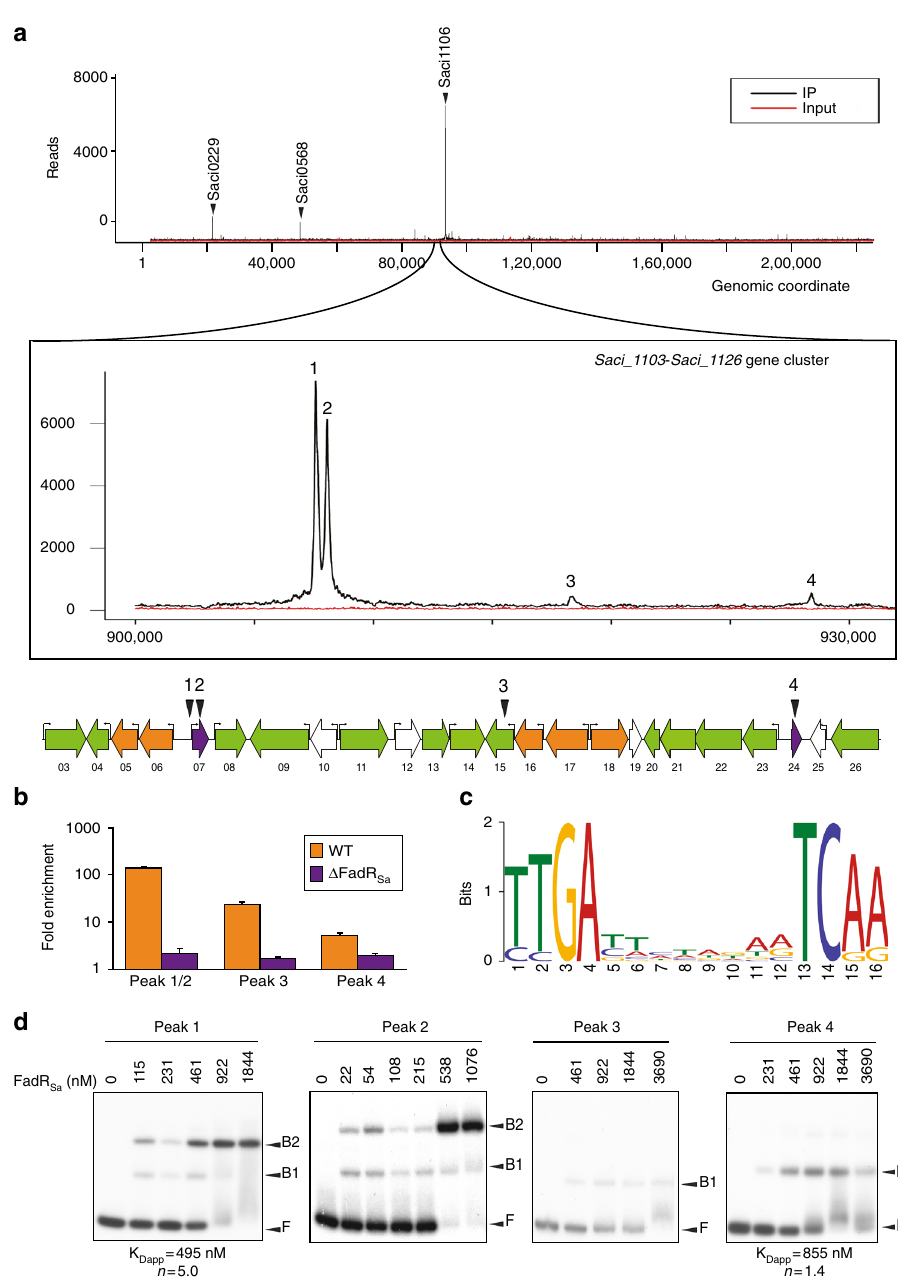
Fig. 2 FadR Sa interacts with four genomic loci in the Saci_1103 - Saci_1126 gene cluster. a Overview of the genomic binding pro fi le of FadR Sa as monitored by ChIP-seq (IP = immunoprecipitated sample). A zoomed image of this pro fi le is shown for the genomic region encompassing the Saci_1103-Saci_1126 gene cluster (corresponding to genomic coordinates 903,000 – 932,000), with indication of the four clearly visible peaks (numbered 1 – 4). Below the pro fi le, a schematic representation of the genomic organization of the Saci_1103 - Saci_1126 gene cluster is shown with indication of the ChIP-seq peak summit locations and of the transcription start sites as detected in the transcriptomic analysis in ref. 37 . b ChIP-qPCR experiment with targeted quanti fi cation of enrichment for peaks 1 and 2 (given their close proximity to each other, these are assayed within a single fragment representing the Saci_1106 / Saci_1107 intergenic region), peak 3 and peak 4. Fold enrichment is expressed relative to a genomic region within the ORF of Saci_1336 that was shown not be bound by FadR Sa in the ChIP-seq pro fi le. Error bars represent standard deviations of biological duplicates. c Sequence logo of the FadR Sa binding motif representing MEME predictions of ChIP-seq enriched sequences. d Electrophoretic mobility shift assays of FadR Sa binding to radiolabeled DNA probes of about 500 bp representing the ChIP-seq peaks identi fi ed in the Saci_1103 - Saci_1126 gene cluster (see panel ( a )). Molar protein concentrations are shown above each autoradiograph, whereas populations of free DNA (F) and FadR Sa -bound DNA (B1 and B2) are indicated with an arrowhead. Apparent K D and Hill coef fi cient ( n ) calculations are based on densitometric analysis of free DNA bands followed by binding curve analysis (Supplementary Figure